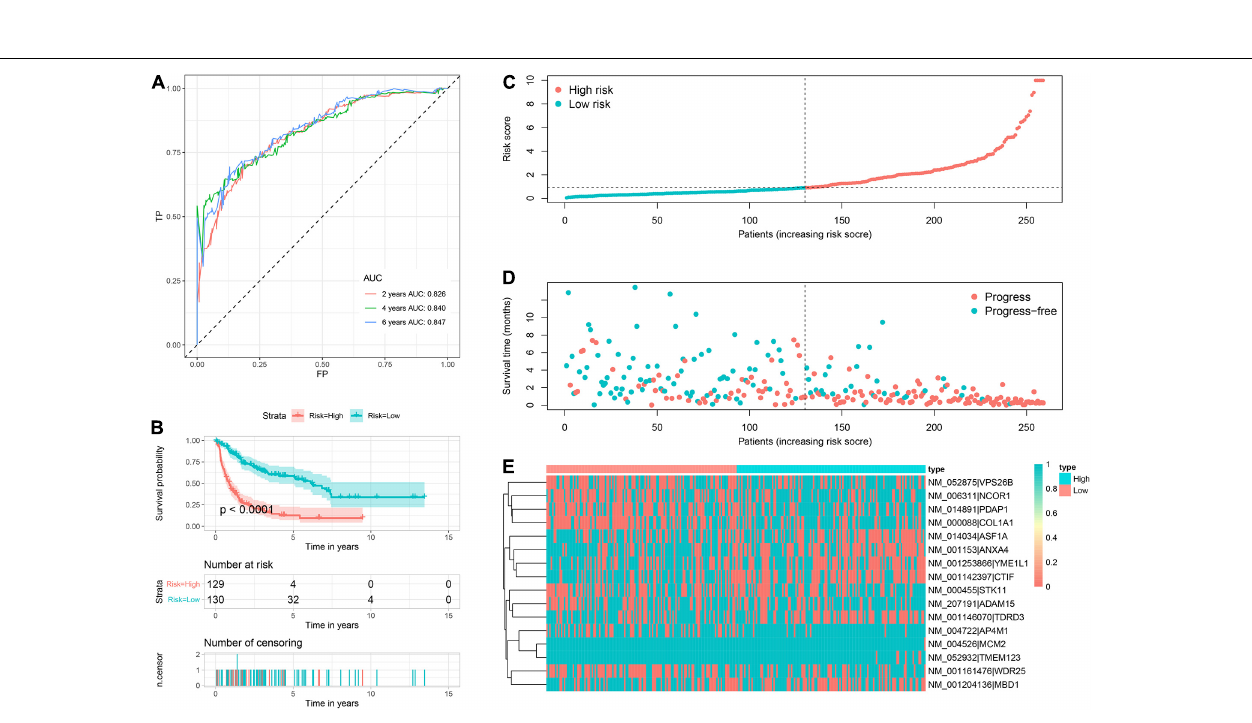
Frontiers in Cell and Developmental Biology |